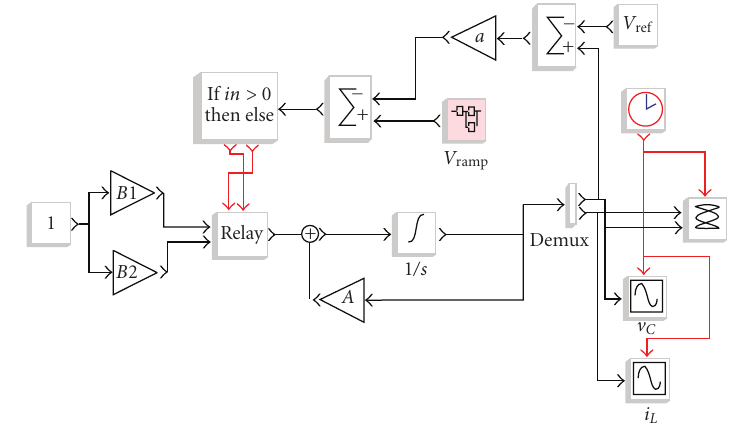
Figure 2: Scicos schematic diagram.